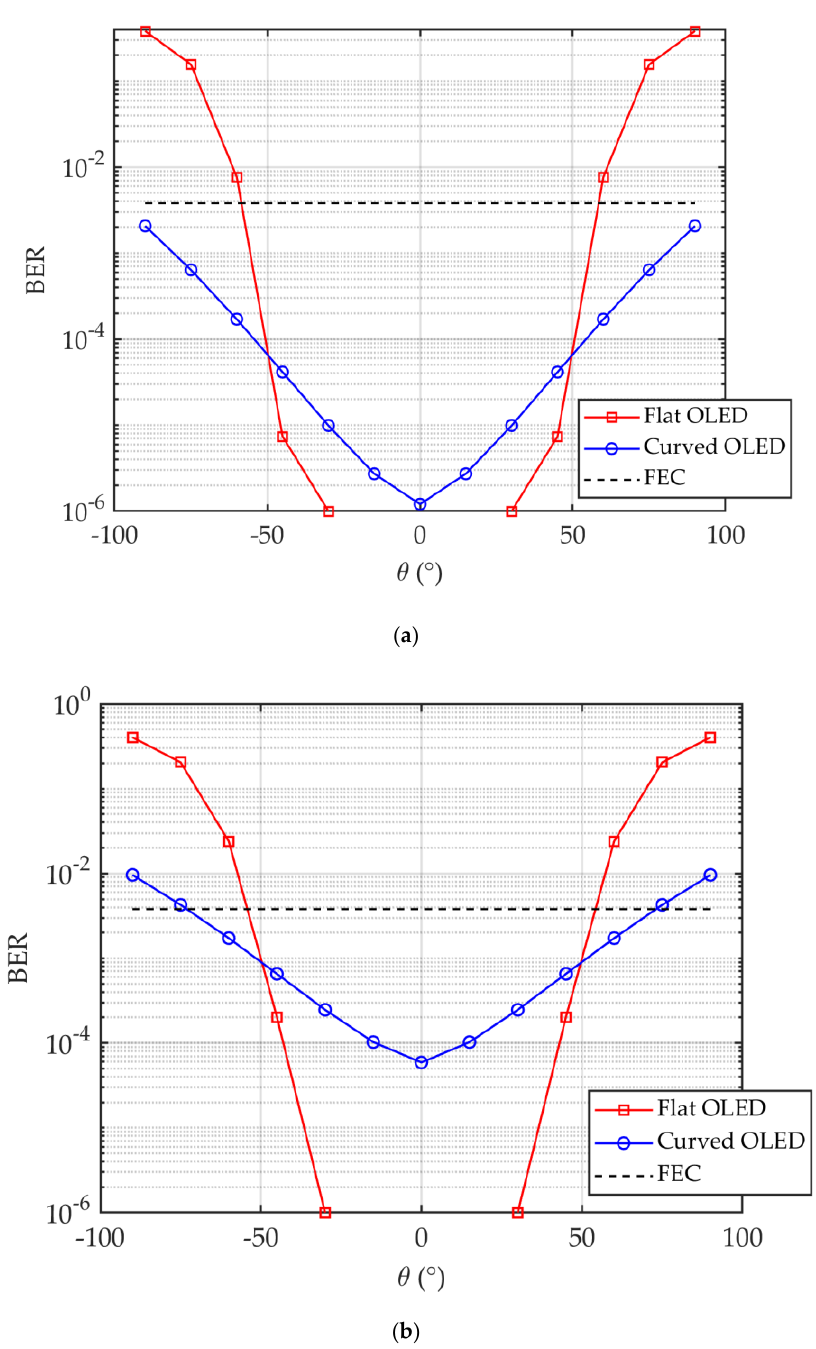
Figure 6. The bit-error-rate (BER) for flat and curved OLEDs at R b of: ( a ) 4 Mb/s, and ( b ) 6 Mb/s for an office.